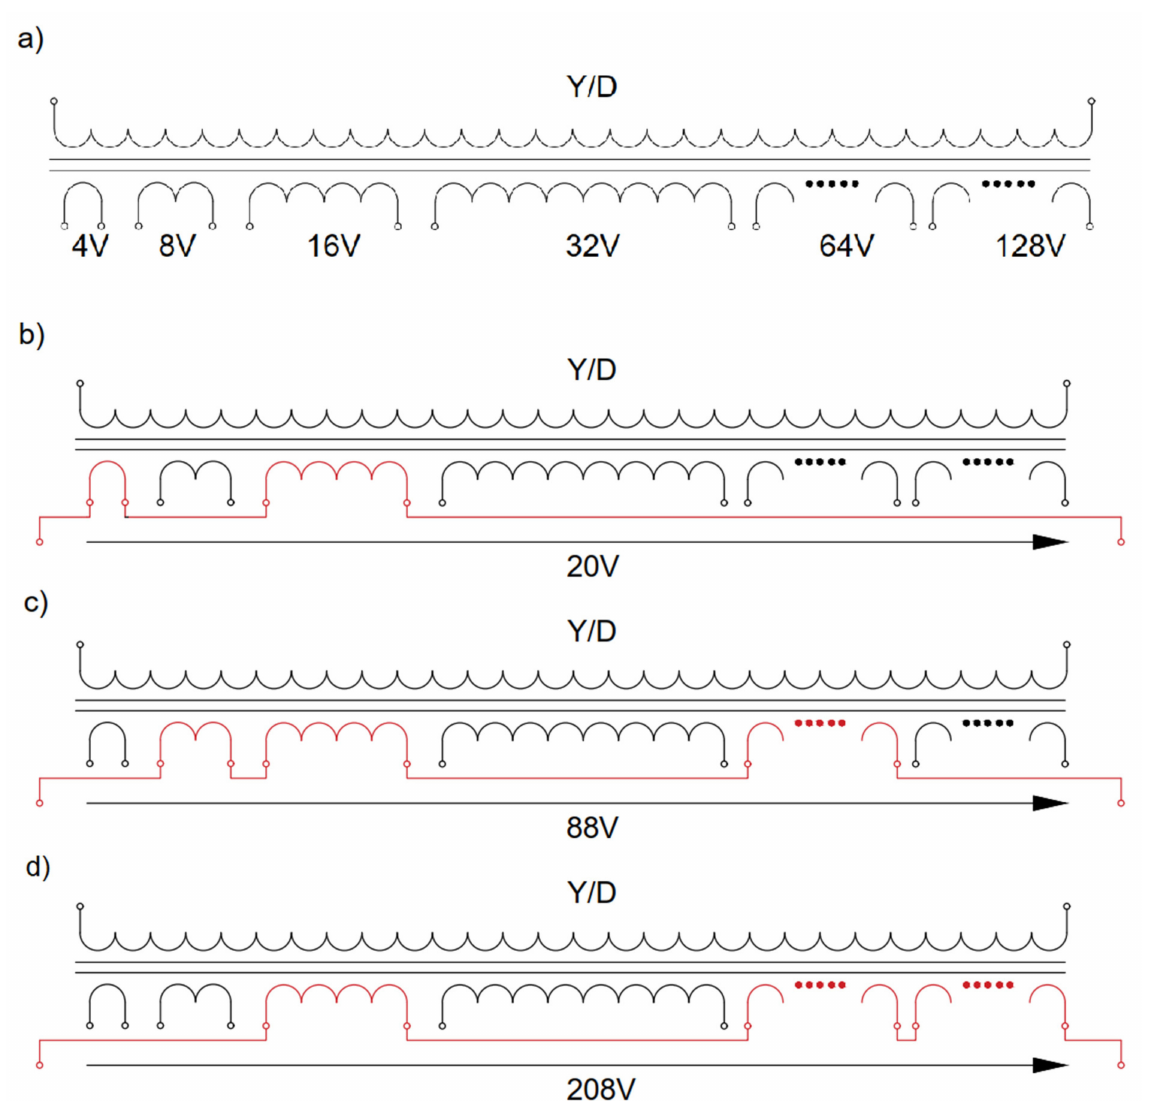
Figure 6. Diagram of the series transformer (ST) windings connection—single-phase equivalent; ( a ) general series winding arrangement, ( b ) 20 V quadrature voltage construction, ( c ) 88 V quadrature voltage construction, ( d ) 208 V quadrature voltage